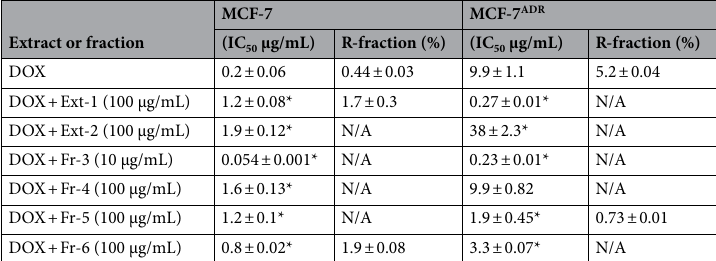
Table 3. Chemomodulatory effects of P. niruri extracts and fractions on the cytotoxicity of DOX against MCF-7 and MCF-7 ADR cell lines . # N/A means not applicable. Data are presented as mean ± SD; n = 3. *Significantly different from DOX treatment.